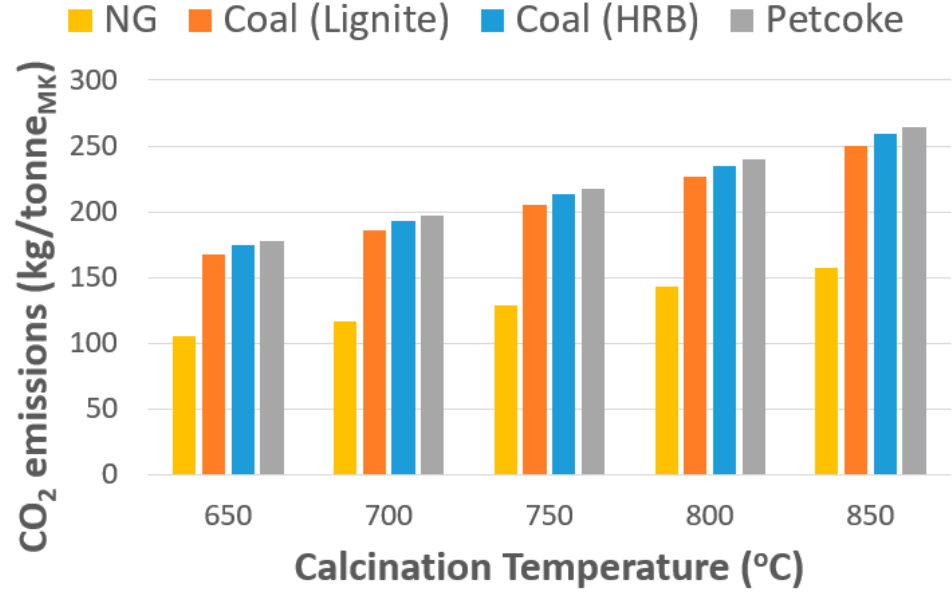
Figure 8. Calculated CO 2 emissions (kg/tonne MK ) for MK production process. (C-EGR scenario/Kiln Temperature: 650–850 °C/Reference moisture content: 15% wt).